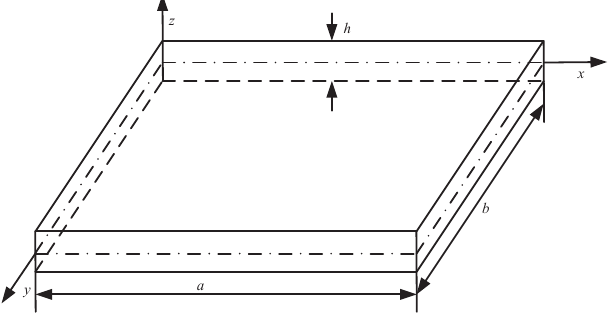
Figure 4. The square diaphragm with four fixed